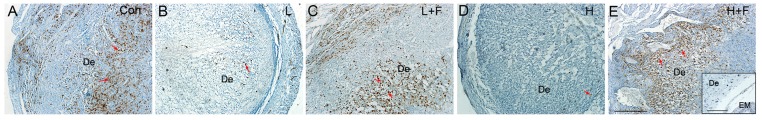
Effect of testosterone and flutamide on the uNK cells.Immunostaining of DBA lectin indicated the uNK cells of uteri in mice. Brown-yellow staining indicates positive signals (red arrows). (A) Con, Control group; (B) L, 0.1 mg testosterone propionate (TP) /per mouse; (C) L+F, 0.1 mg TP + 0.15 mg flutamide/per mouse; (D) H, 1 mg TP/per mouse; (E) H+F, 1 mg TP + 0.15 mg flutamide/per mouse. Inset of E is negative control (the addition of N-acetyl-D-galactosamine to the DBA lectin incubation). EM: embryo; De: deciduas. Scale bars, 50μm.